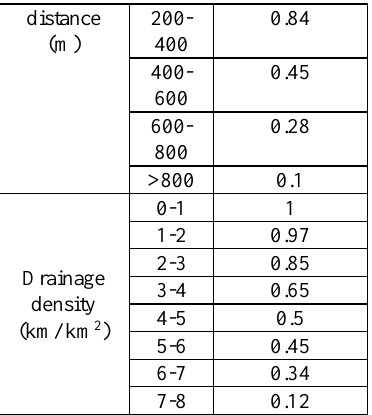
Table1. Fuzzy membership function for data sets